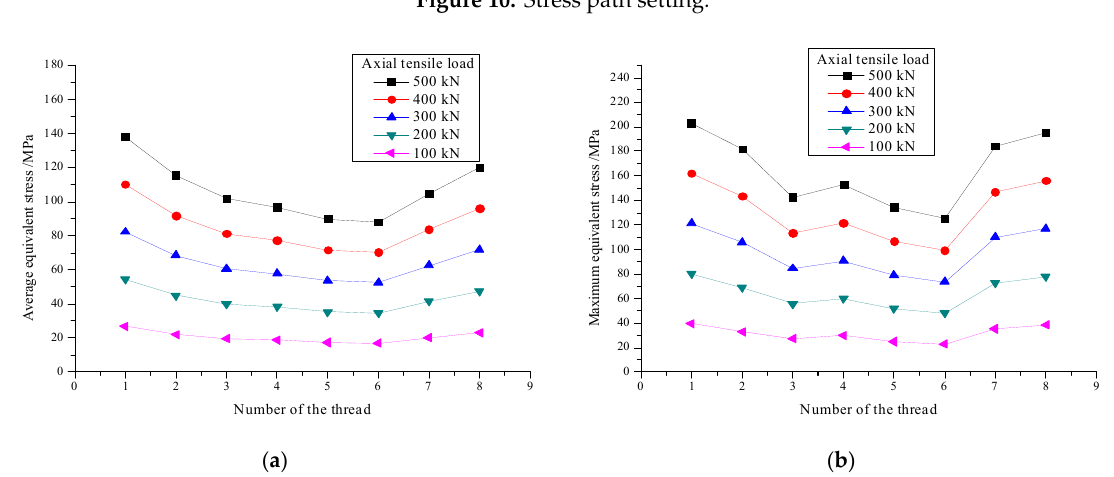
Figure 11. Equivalent stress distribution in the thread: ( a ) average equivalent stress and ( b ) maximum equivalent stress.